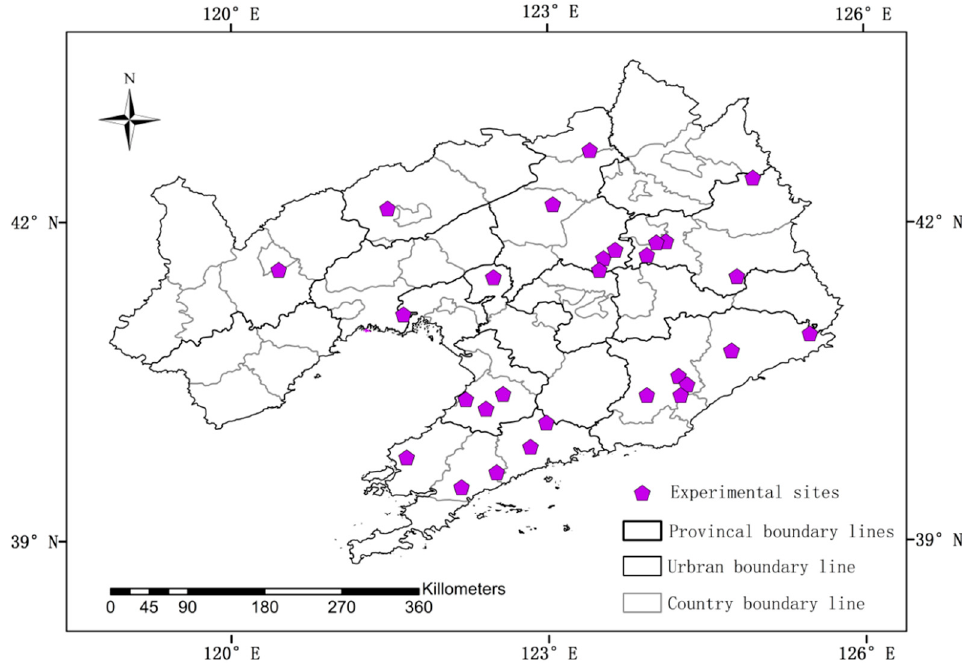
Figure 1. Location of distribution of 29 experimental sites for soybean in Liaoning province of China.